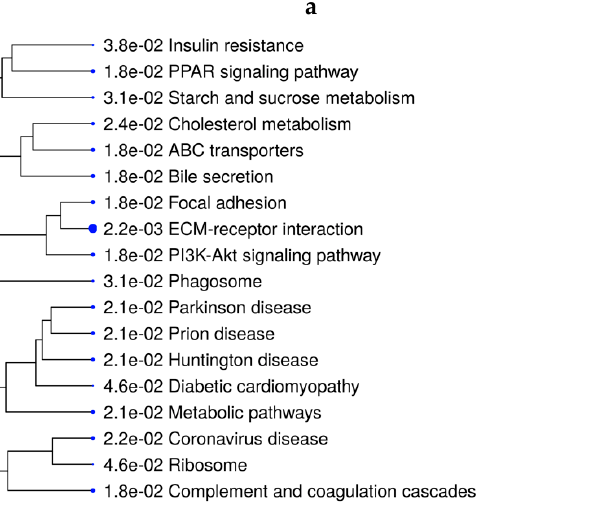
Figure 2. Functional over-representation analysis of differentially expressed genes (DEGs) from fetal liver tissues. KEGG pathways over-represented are based on the DEGs of VTM_MG vs. VTM_LG ( a ) and NoVTM_MG vs. NoVTM_LG ( b ) comparisons. The terms are hierarchically arranged based on functional similarity. The bigger the blue dot, the more significant the term is (FDR ≤ 0.05). The over-represented BPs underlying the DEGs from the main effect of rate of gain were related to lipid metabolism, lipid storage, and the fatty acid metabolic process (Tables S3 and S8). When evaluating the effects of vitamin–mineral supplementation for each rate-of-gain condition (VTM_MG vs. NoVTM_MG and VTM_LG vs. NoVTM_LG—Figure 3a,b), mineral-homeostasis- and amino acid-transport-related terms were over-represented in fetuses receiving in utero VTM supplementation.